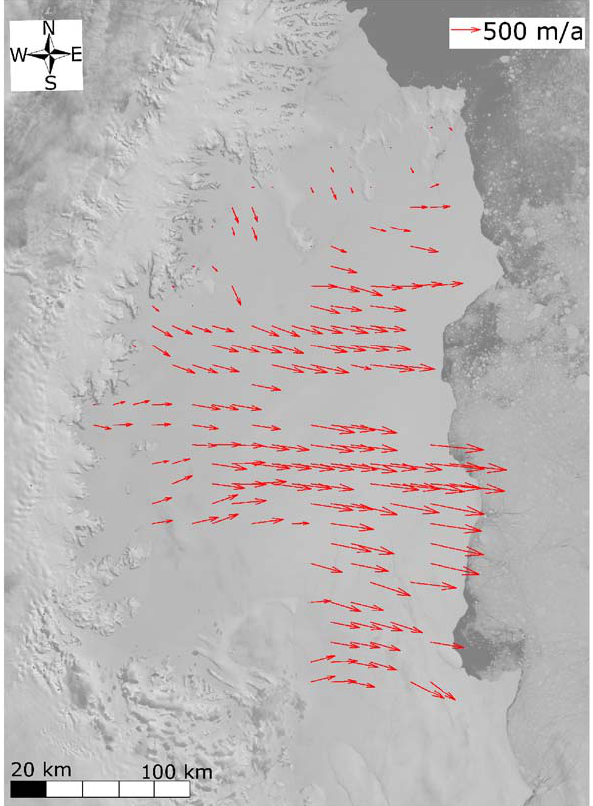
Fig. 5. Average annual velocity between 2002 and 2009 measured with orientation correlation on MODIS